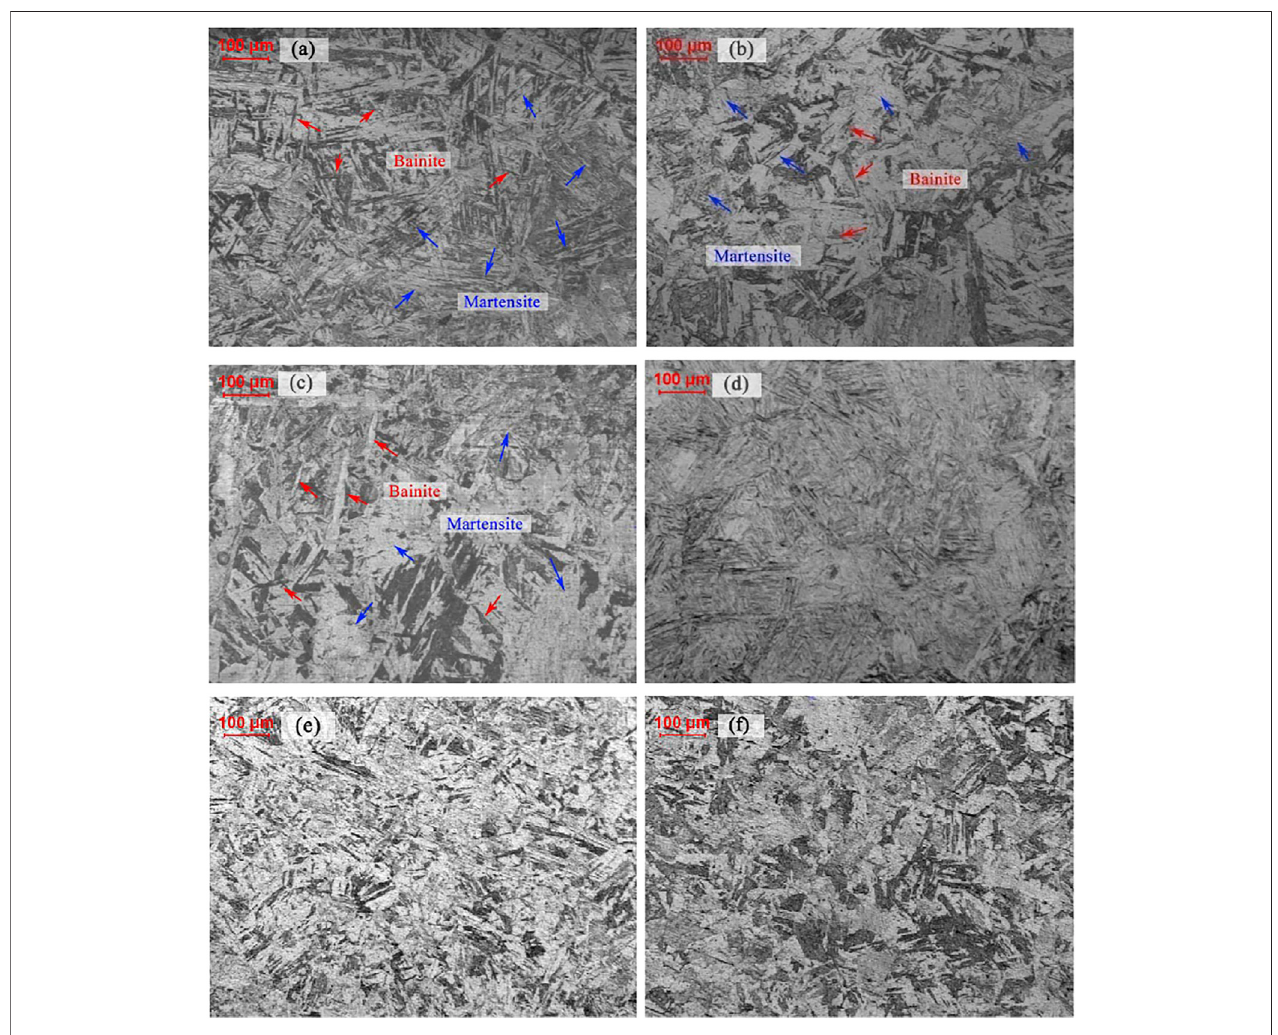
FIGURE2| Microstructure ofgroupBNSMsteelspecimensisothermallyheld for5 minwithacooling rateof (A) 0.02 ° C/s, (B) 0.05 ° C/s, (C) 0.1 ° C/s, (D) 1 ° C/s, (E) 2 ° C/s and (F) 5 ° C/s.